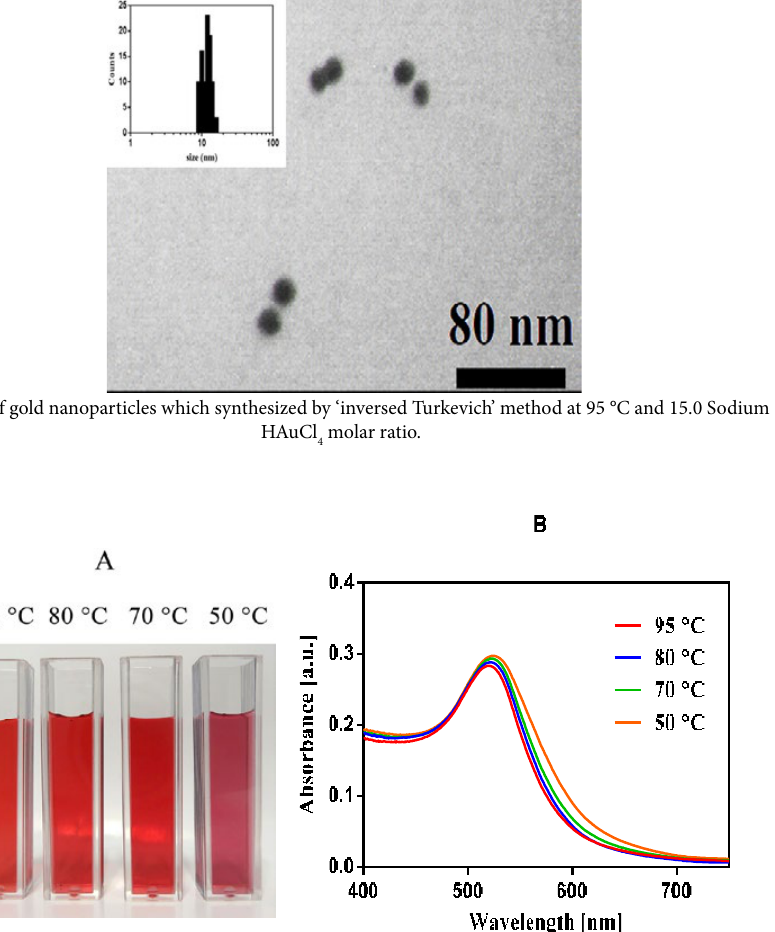
Fig. 4. Image (A) and UV-vis spectra (B) of gold nanoparticles samples that synthesized via ‘inversed Turkevich’ method at various temperatures: 95 °C, 80 °C, 70 °C and 50 °C.